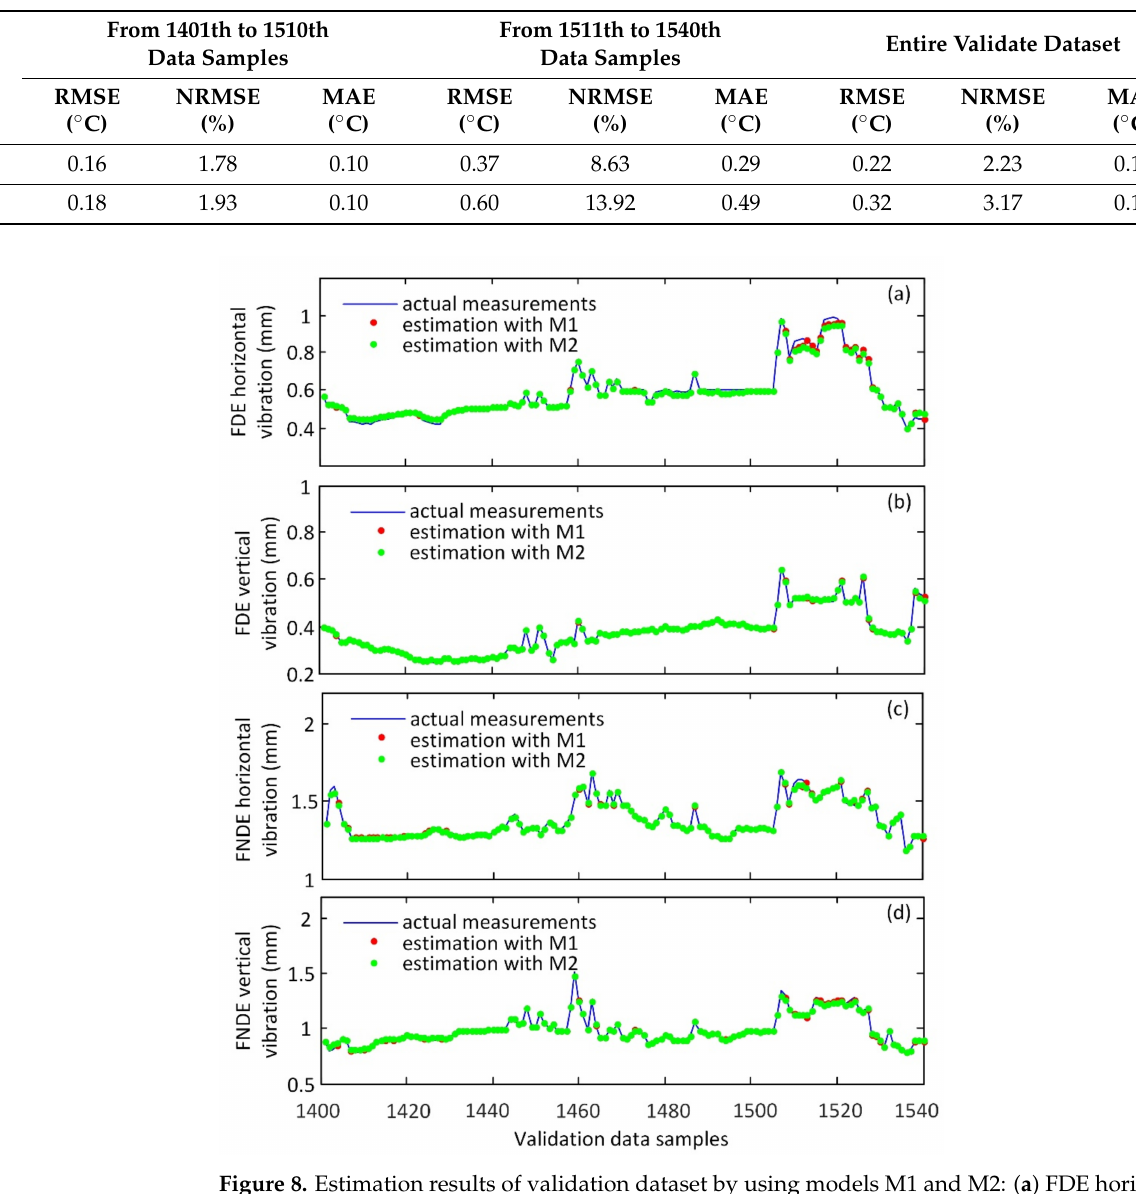
Figure 7. Estimation of motor power in validation dataset by using models M1 and M2. Table 4. Estimation errors of FDE bearing temperature in validation dataset.